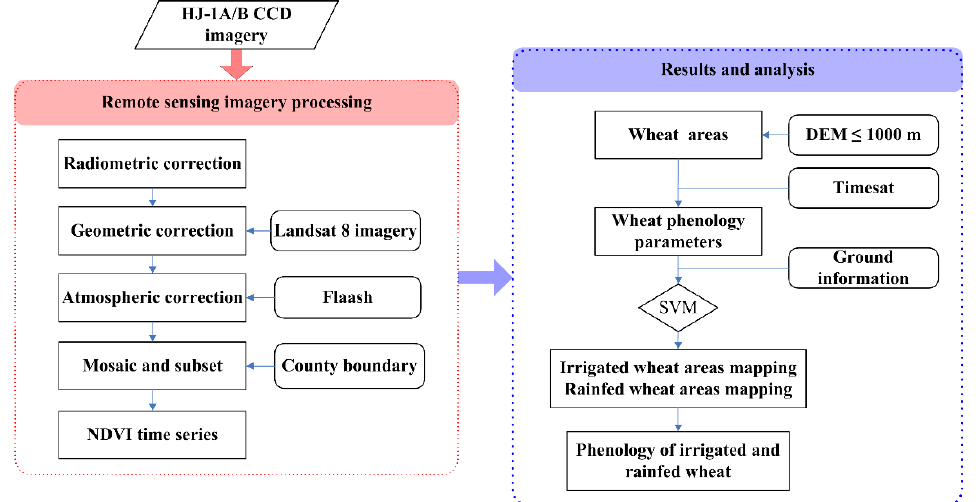
Figure 2. Flowchart of irrigated and rainfed wheat classification.